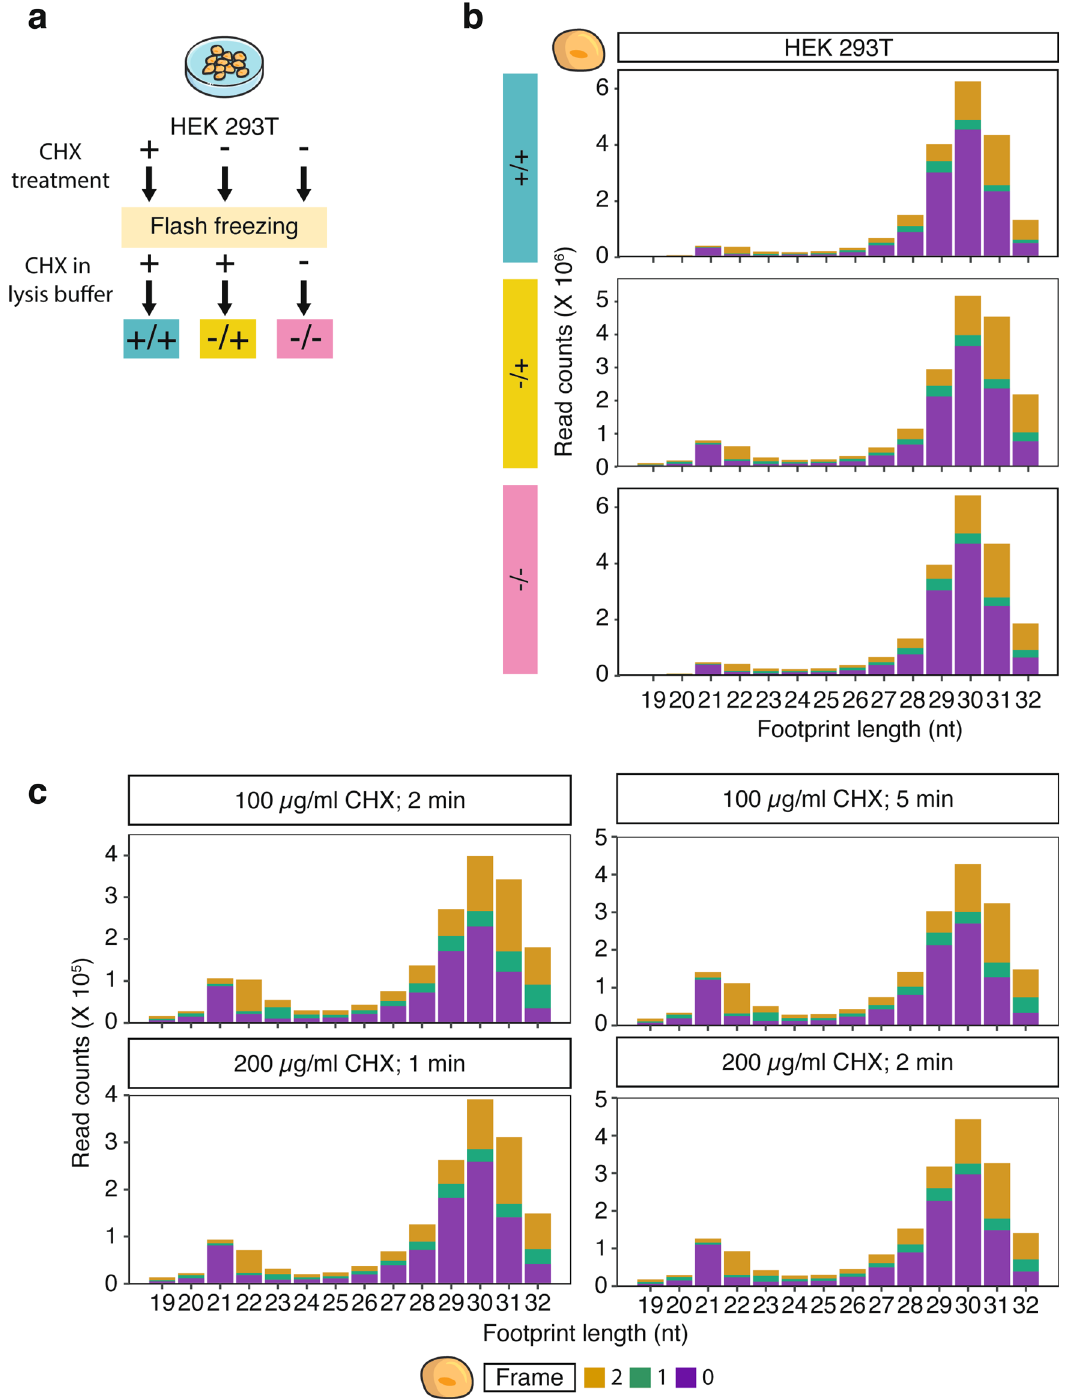
Fig. 1 Cycloheximide (CHX) does not affect ribosome footprint length distribution in HEK 293T cells. a Schematic overview of the harvesting and CHX- treatment conditions used for HEK 293T cells. CHX treatment conditions in this and all fi gures are indicated by color: + / + , green; − / + , yellow; − / − , pink. b Representative histograms showing the in fl uence of CHX on footprint length and reading-frame distribution in HEK 293T libraries. The reading frame in all fi gures is indicated by color: 0, purple; 1, green; 2, yellow. c Same as b for HEK 293T cells treated with different CHX concentrations and incubation period. Footprints were excised between 18 and 32